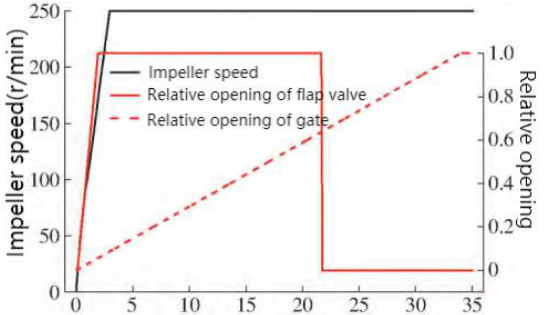
Figure 5. The variation law of impeller speed, relative opening of fast gate, and flap gate [30].